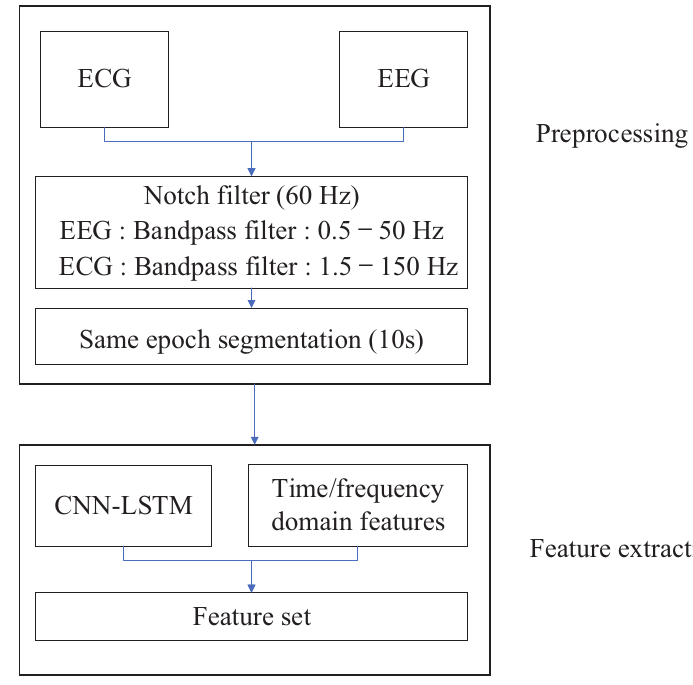
Figure 2. Feature extraction with electroencephalogram (EEG) and ECG